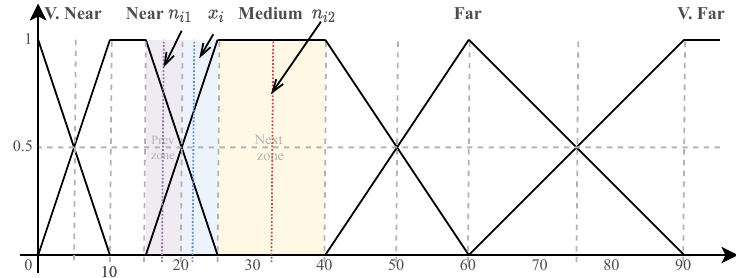
Figure 1. Illustration of the next and prev